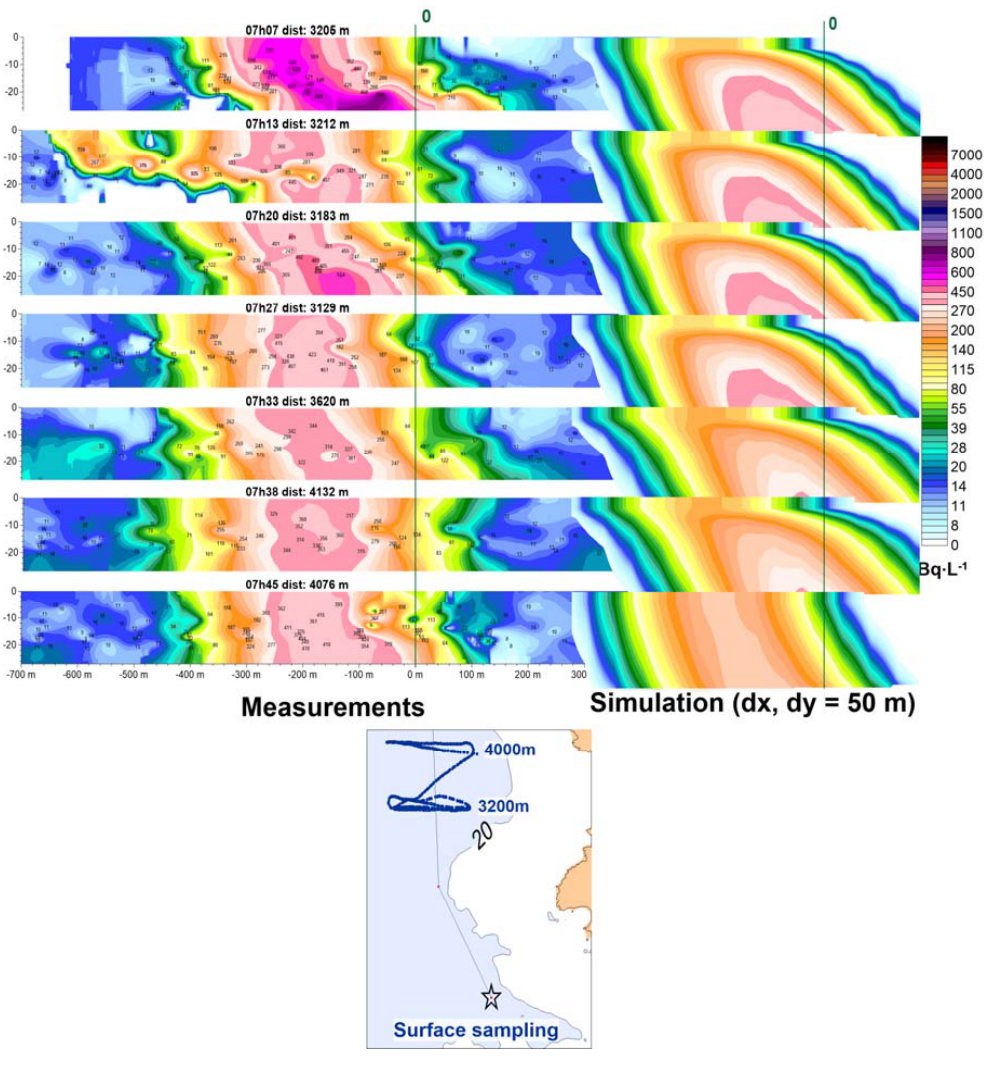
Figure 6. Examples of measurement/model comparison of vertical transects of the plume between 850–1300 m distance from the outfall ( a , 7 October 2010), and 3200–4200 m from the outfall ( b , 6 April 2011), adapted from [61]. Time and spatial scales (m) are the same for measurements and simulations. Insets: maps of surface sampling locations, adapted from [55].